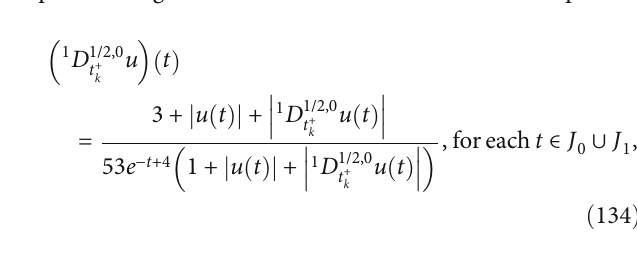
ffiffiffiffiffiffiffiffiffiffi t − t